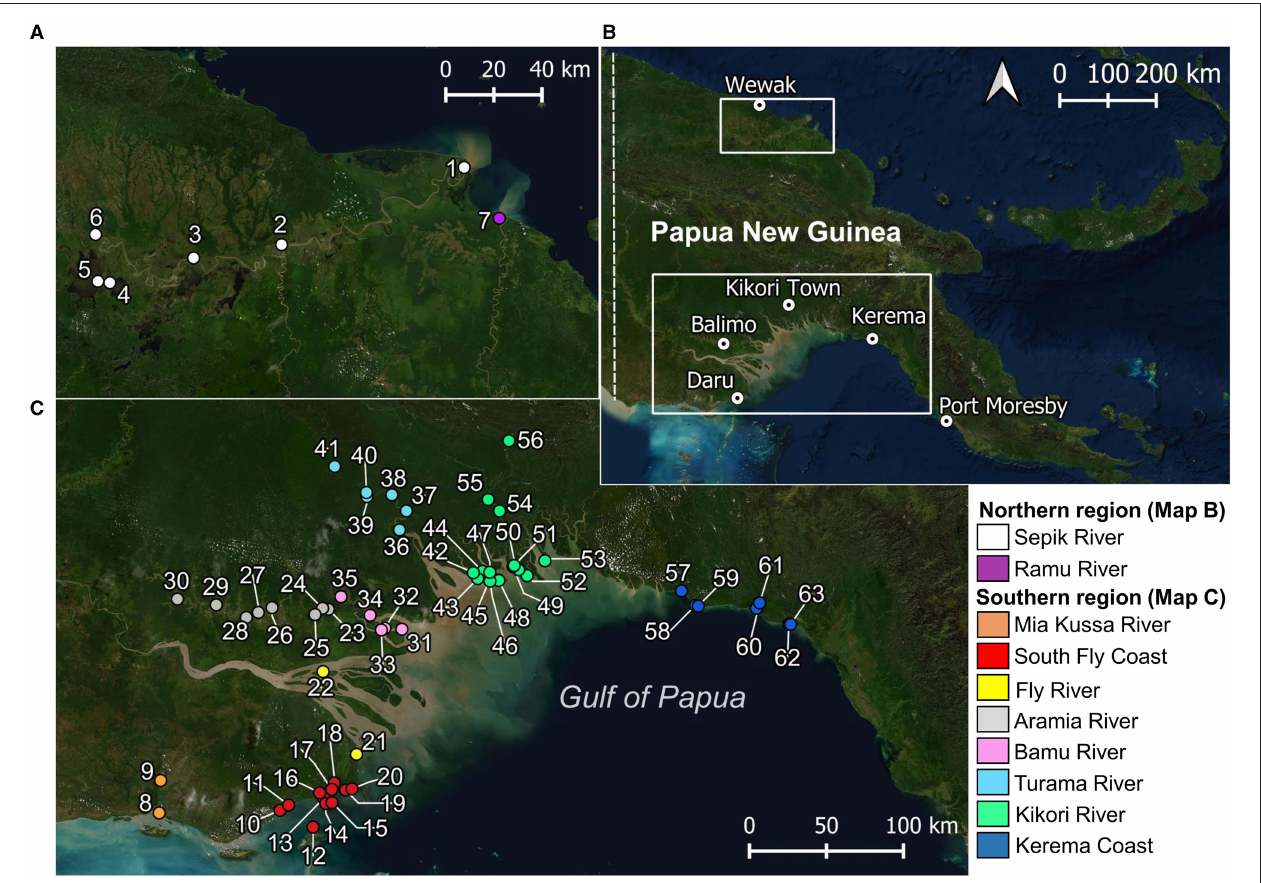
FIGURE 1 | Locations where elasmobranchs (including fins and sawfish rostra) were encountered during surveys. (A) Papua New Guinea mainland, showing major trading centers for regions surveyed; (B) northern region surveyed; and, (C) southern region surveyed. Village names corresponding to each location in (B) and (C) are provided in Supplementary Table 1